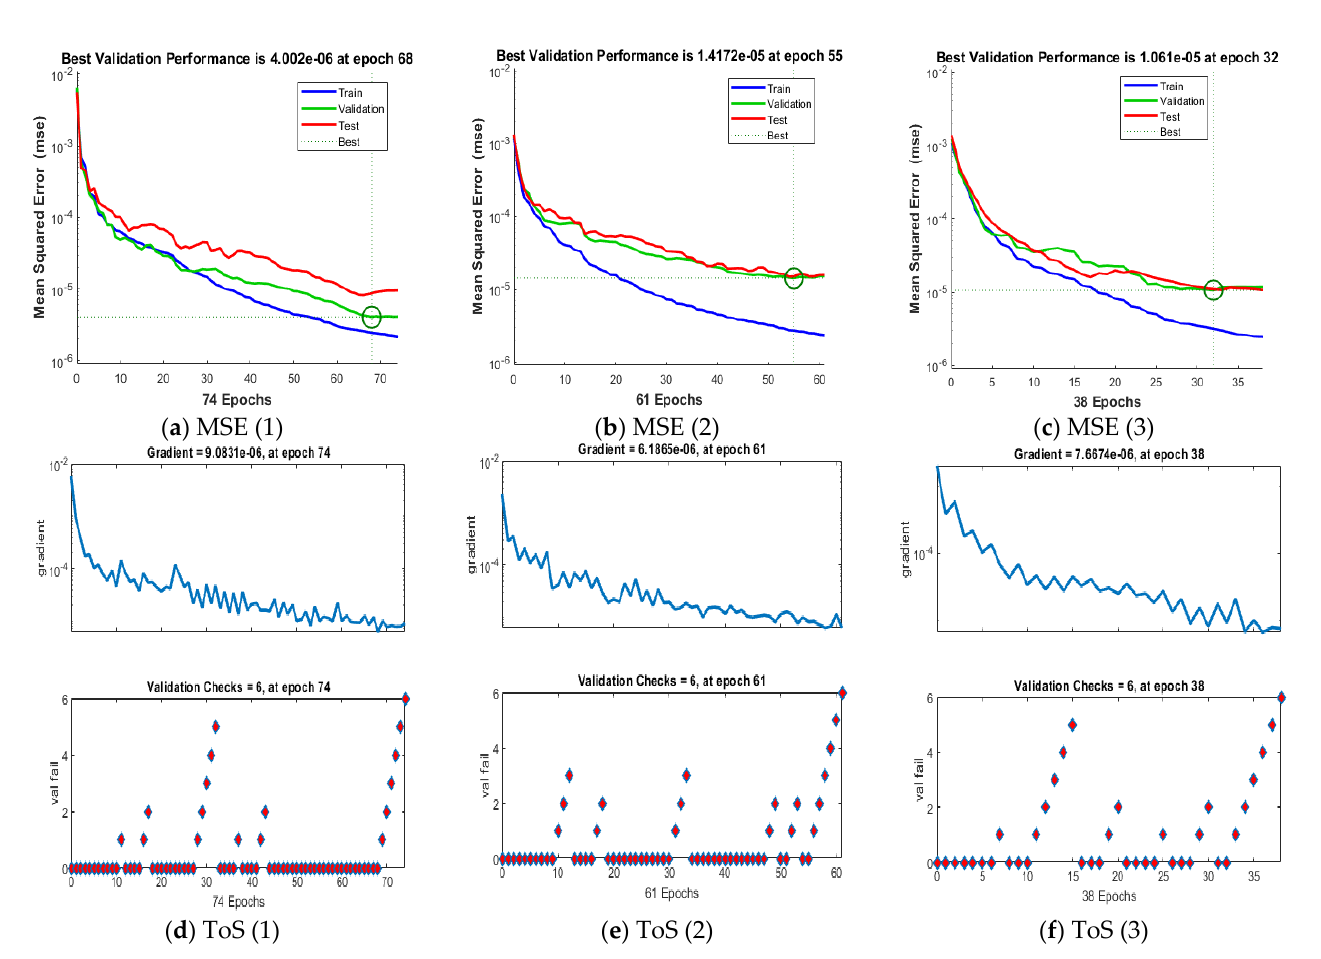
Figure 4. Optimal training and ToS for solving the nonlinear dynamics of MTS.